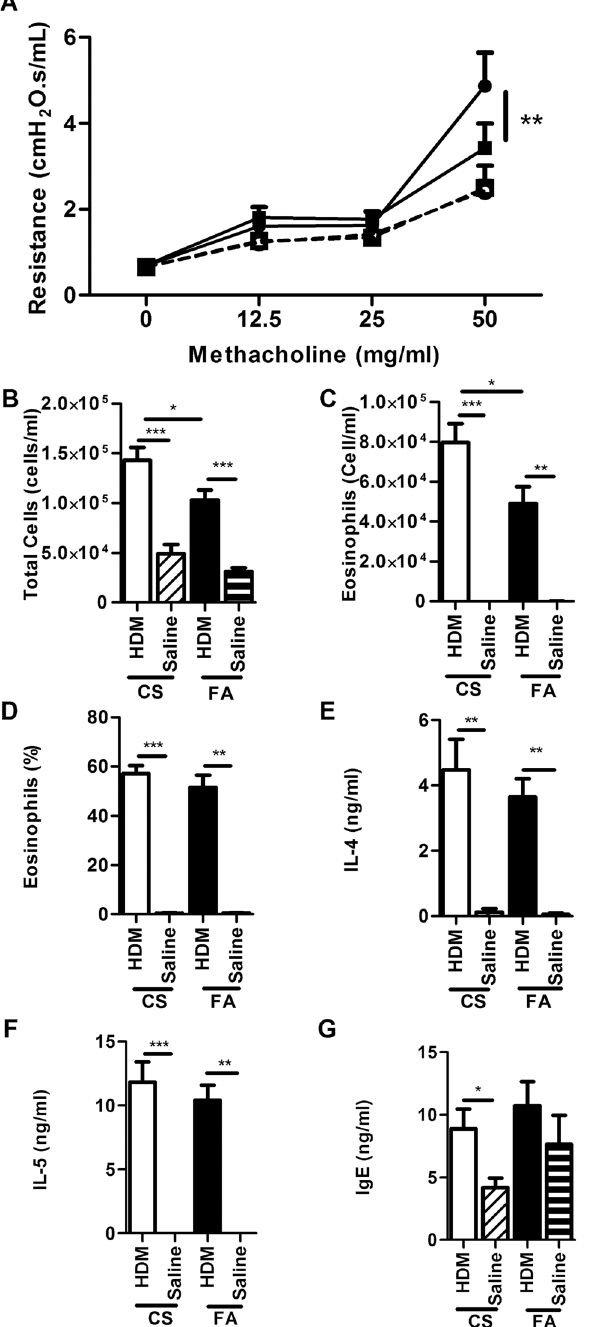
Fig 1. In utero cigarette smoke exposure enhanced the severity of HDM-induced allergic airway disease. (A) airway hyperresponsiveness (HDM-treated FA solid line closed square, HDM-treated CS solid line closed circle, saline-treated FA dashed line open square, and saline-treated CS dashed line open circle), (B) total cell in WLL, and (C) concentration of eosinophils, (D) percentage of eosinophils in the WLL, (E) WLL IL-4 cytokine levels, (F) WLL IL-5 cytokine levels, and (G) total IgE levels in the serum (HDM-treated CS white bar, HDM-treated FA black bar, saline-treated CS white bar with black dots, and saline-treated FA black bar with white dots, * p-value < 0.05, ** p-value < 0.01, *** p-value < 0.001).